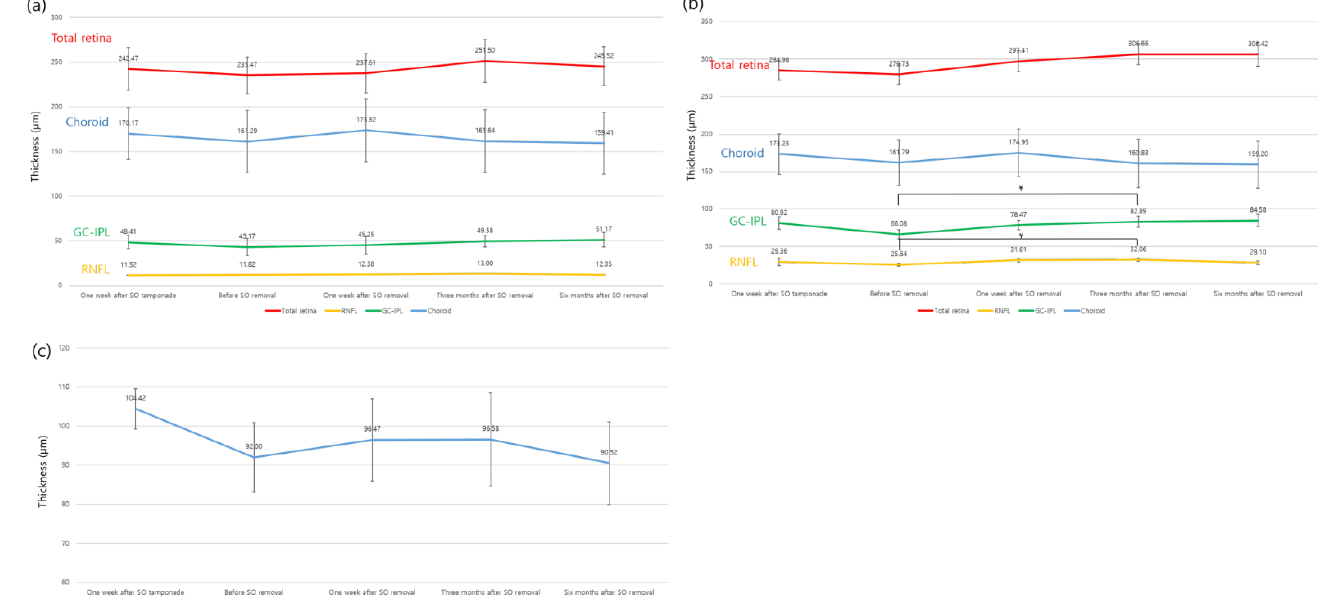
Figure 3. The segmented retinal layer thickness changes from one week after SO tamponade to six months after SO removal. ( a ), fovea, ( b ), parafovea, ( c ), peripapillary retinal nerve fiber layer (RNFL). SO: silicone oil, GC-IPL: ganglion cell-inner plexiform layer. Bar means 95% confidence interval. * Statistically significant difference ( p < 0.05) by post hoc analysis between before SO removal and three months after SO tamponade.